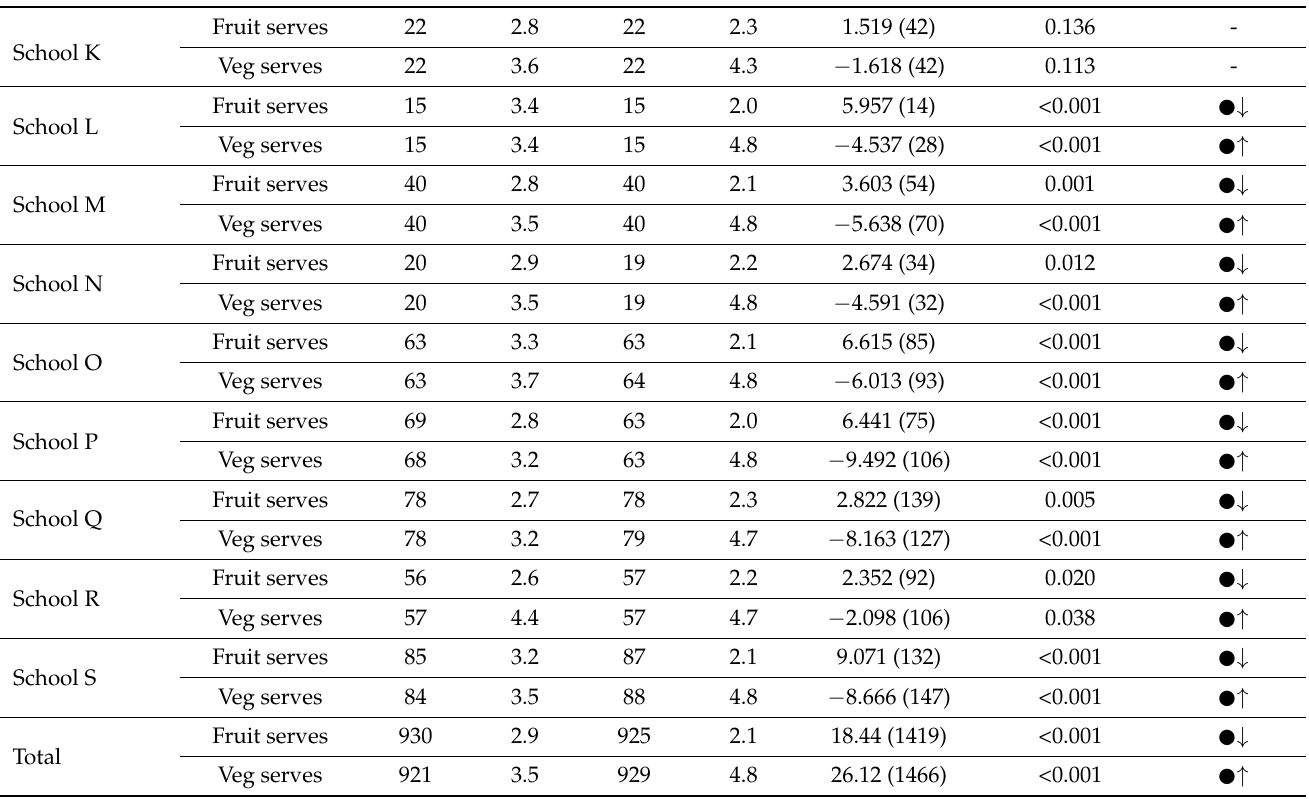
Table 2. Coding of ingredients listed in children’s’ descriptions of healthy snacks.